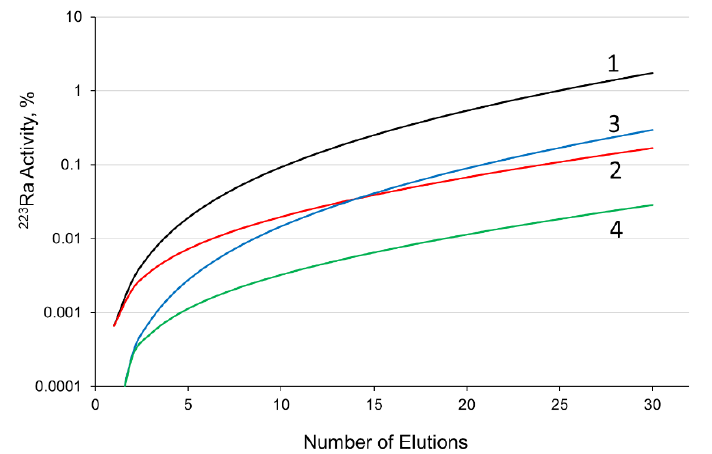
Figure 12. Estimation of maximal 223 Ra amount in the generator “Afrabis” producing 213 Bi once a day in a four hour cycle: 1—without preconditioning the mother column or replacing the second column (black line); 2—with replacing the second column after each cycle (red line); 3—with preconditioning the mother column before each cycle (blue line); 4—with preconditioning the mother column and replacing the second column every time (green